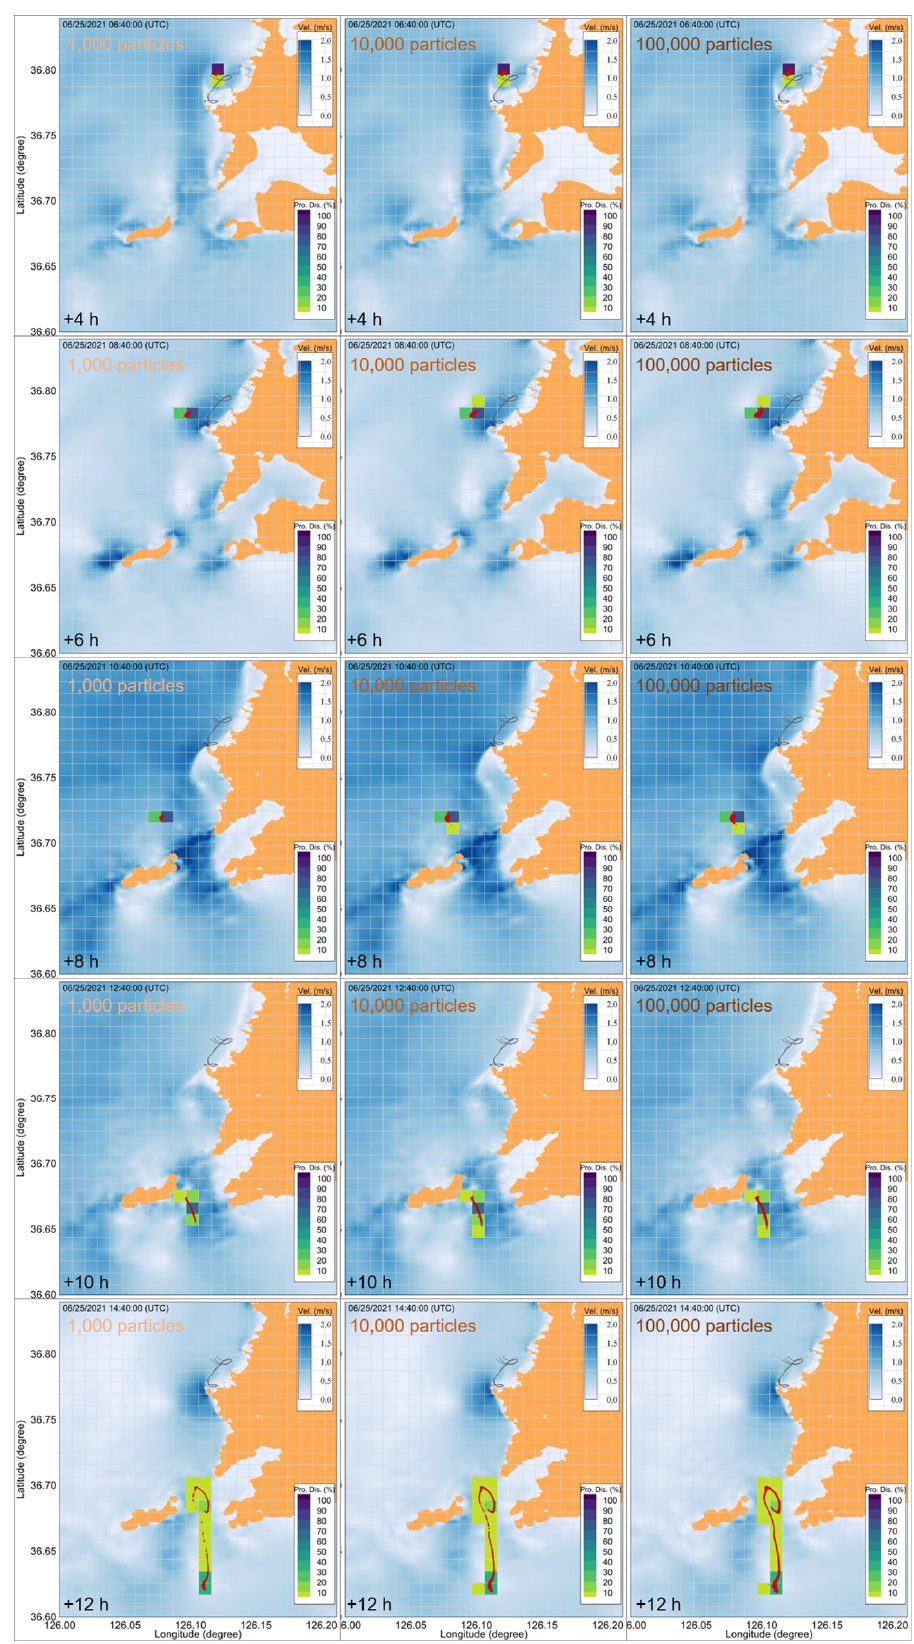
Figure 11. Temporal (elapsed time denoted as in the lower-left corner) probability distribution for the 1 × 1 km detecting cell of mannequin